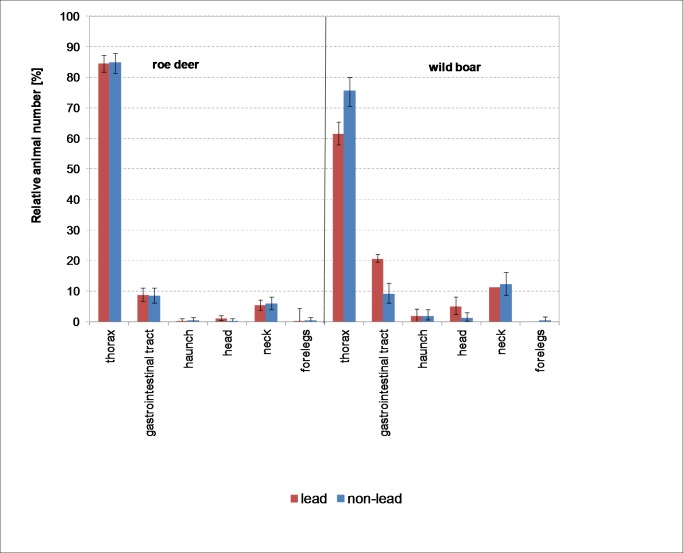
Distribution of shot placement in roe deer and wild boar by bullet material (error bars: 95% CI).